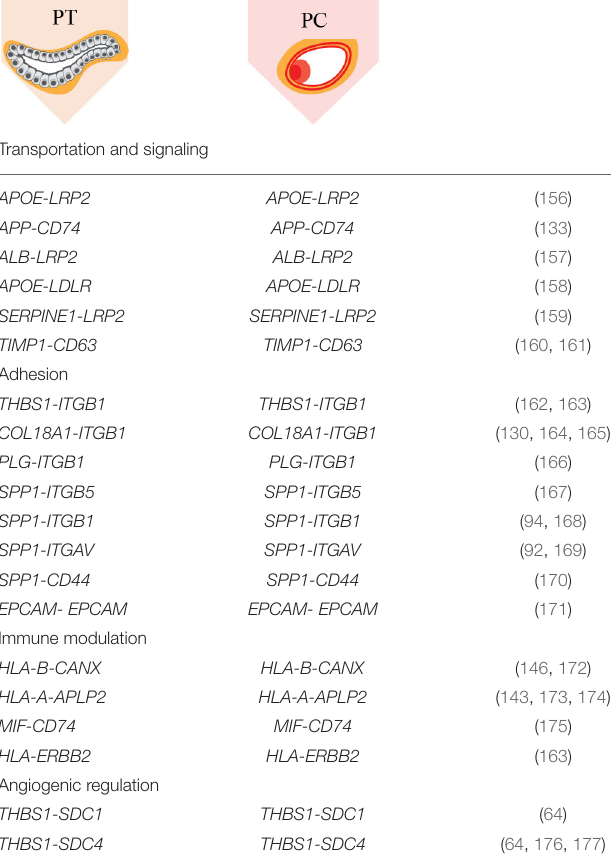
TABLE 3 | CCI identified within and between proximal tubule and endothelial